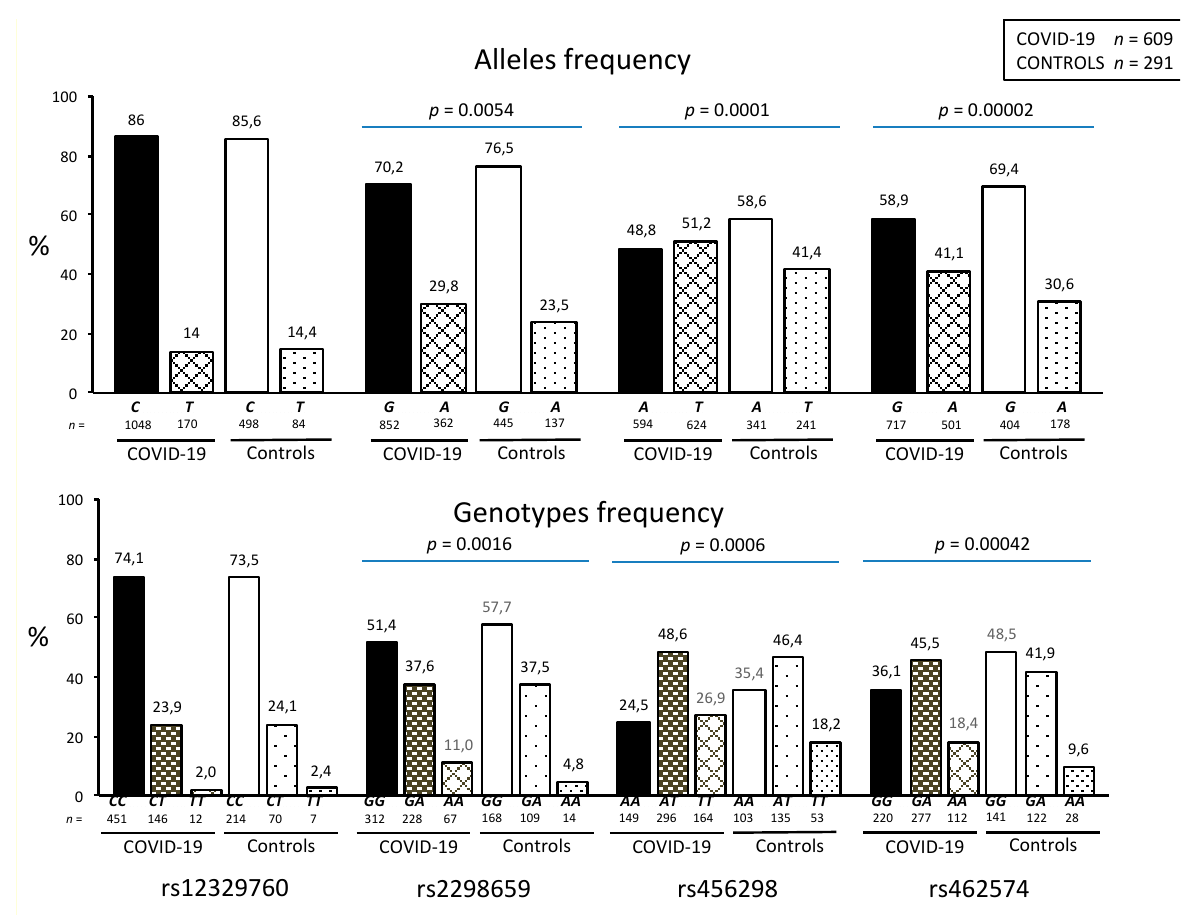
Figure 2. Allele and genotype distribution of TMPRSS2 gene polymorphisms in COVID-19 patients and healthy controls. Data are shown as frequency in percentage. We use Chi-square test to test differences between alleles frequencies and among genotype frequencies. The rs2298659 was determined in 607 COVID-19 patients.